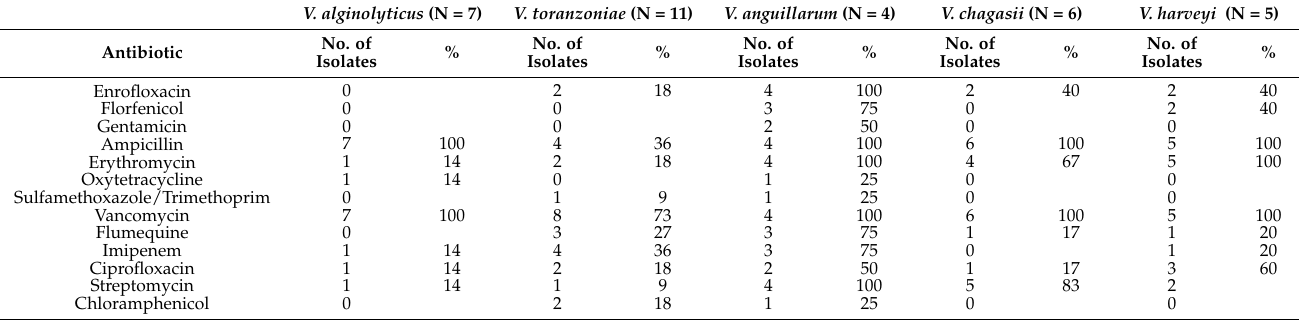
Table 7. Antibiotic resistance of bacteria from the genus Vibrio